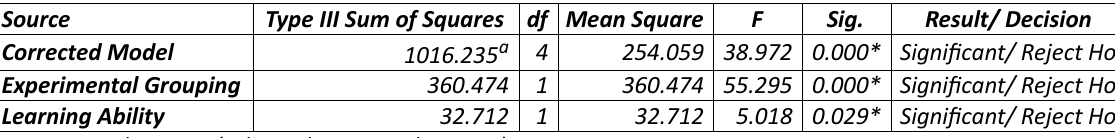
Table 2. The Two-way Analysis of Covariance on the Tests